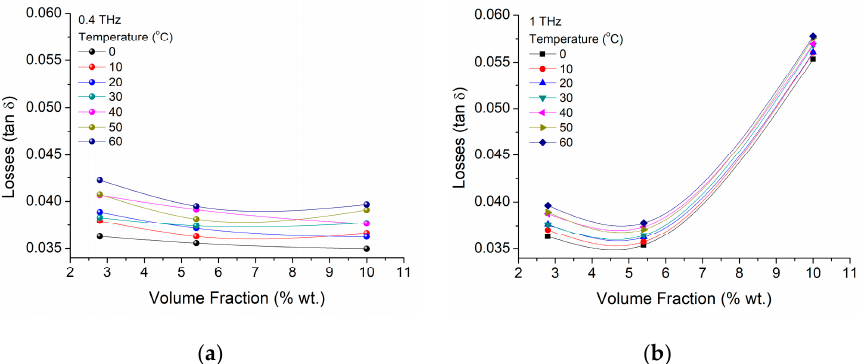
Figure 11. BTO-epoxy losses variation on nanoparticle volume fraction variation at frequencies of ( a ) 400 GHz and ( b ) 1 THz for different temperatures.